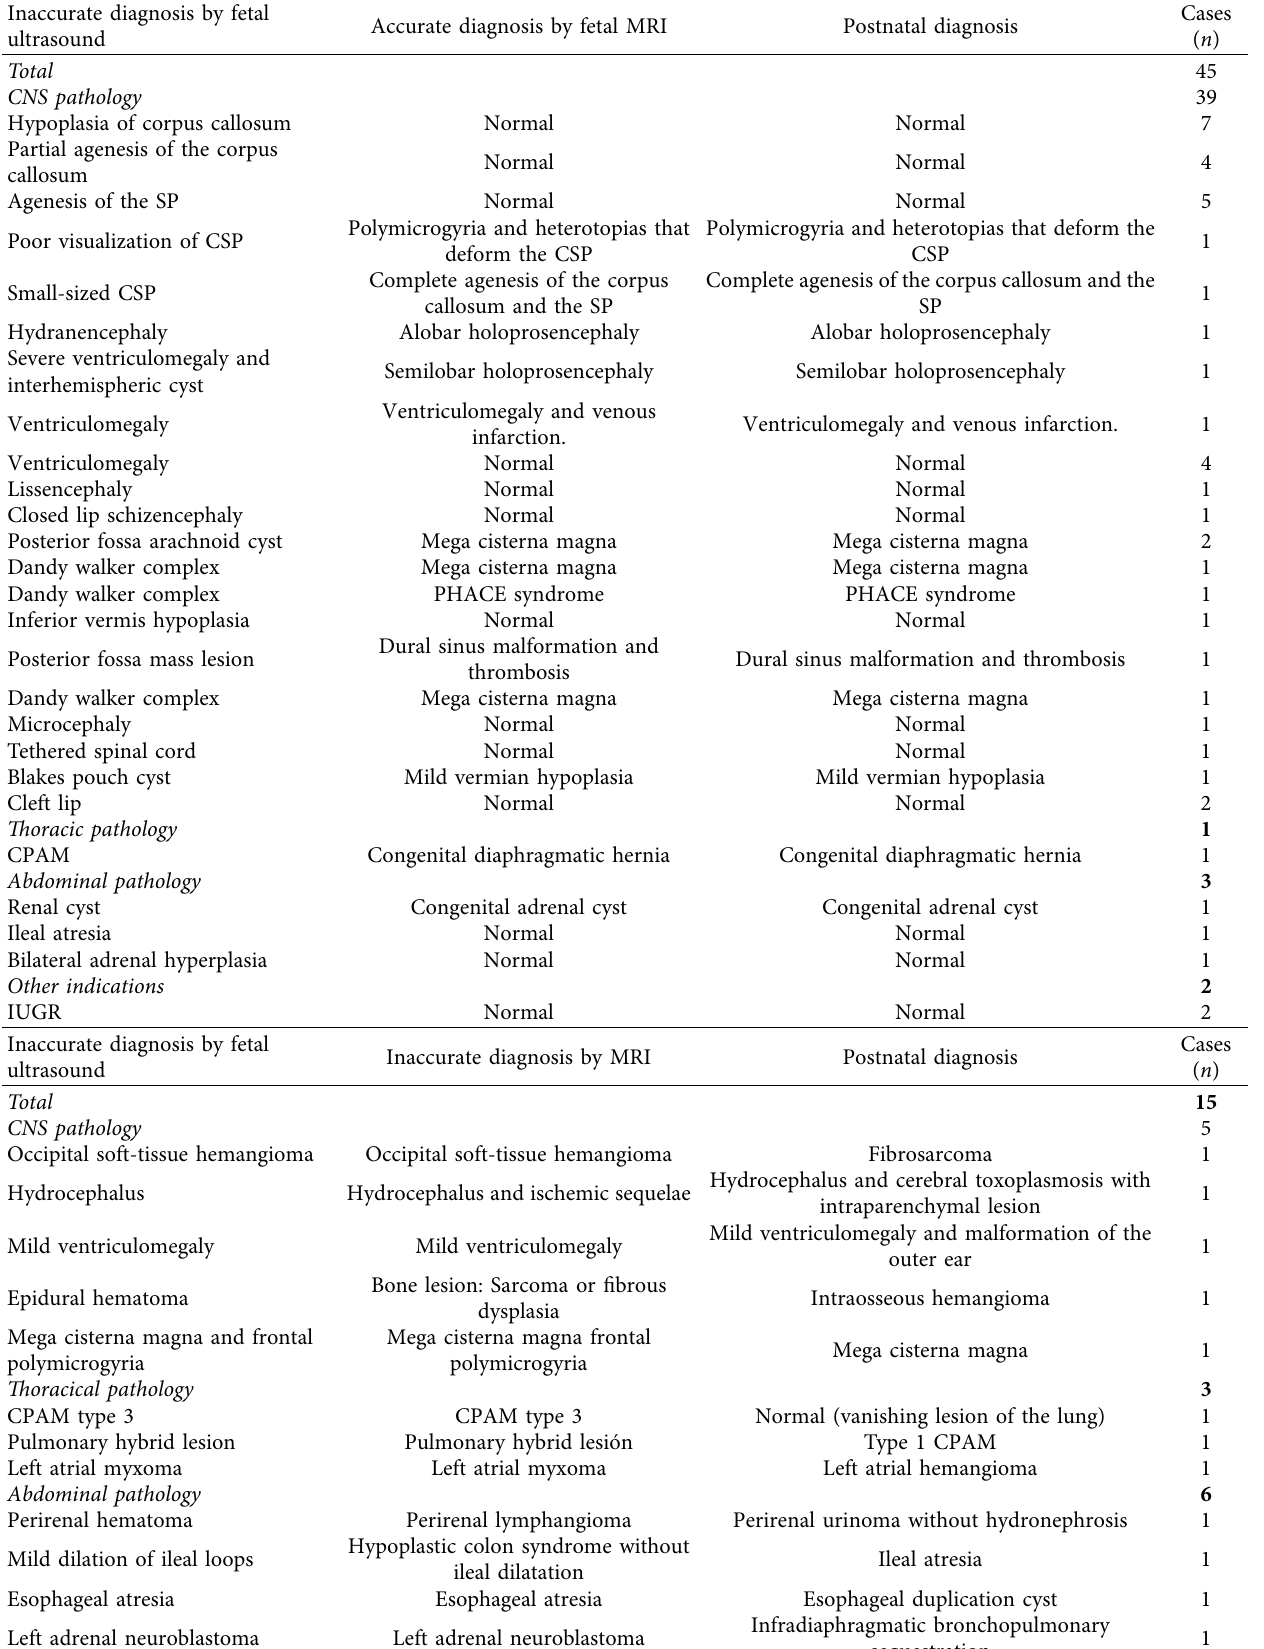
Table 4: Cases with inaccurate diagnosis by fetal ultrasound and/or fetal magnetic resonance imaging